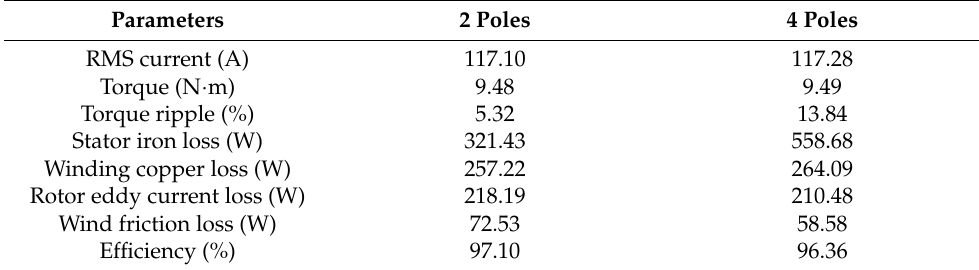
Figure 3. The comparisons of current and torque waveforms of the HSPMM under full-load condi- tions. ( a ) Current waveforms; ( b ) torque waveforms. Table 3. Performances of 2 and 4 poles HSPMMs under full − load condition.